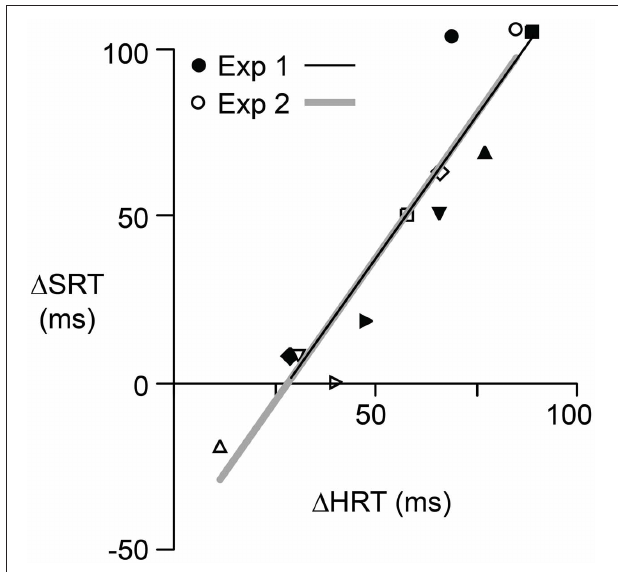
FIGURE 4 | The relationship between (cid:2) SRT and (cid:2) HRT for each participant in Experiment 1 (filled symbols) and Experiment 2 (open symbols). (cid:2) represents the effect of reversal adaptation, i.e., the difference between pre- and post-adaptation reaction time when the eyes and hand moved concurrently. A positive value indicates the reaction time was longer after adaptation. Different symbols are used for each of the six participants. Separate regression lines are shown for each experiment. However, these two lines have similar slopes and